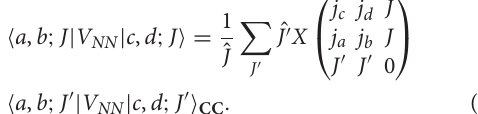
Frontiers in Physics |